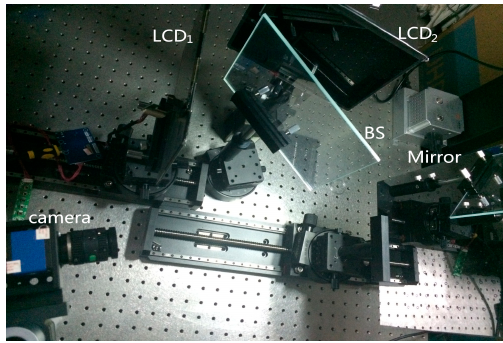
Figure 7. Setup for the experiments using the DPMD technique.